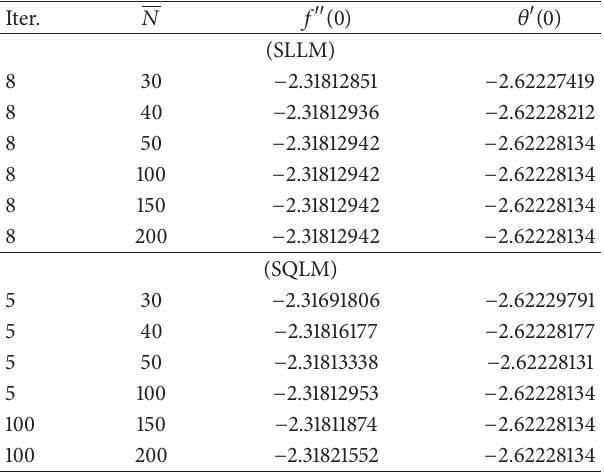
Table 4: Effect of varying 𝑁 on 𝑓 󸀠󸀠 (0) and 𝜃 󸀠 (0) using the SLLM, when 𝐾 = 1 , Gr = Gc = 𝐴 = 1 , and 𝑓 𝑤 = 2 , 𝛾 = 0 . Iter.